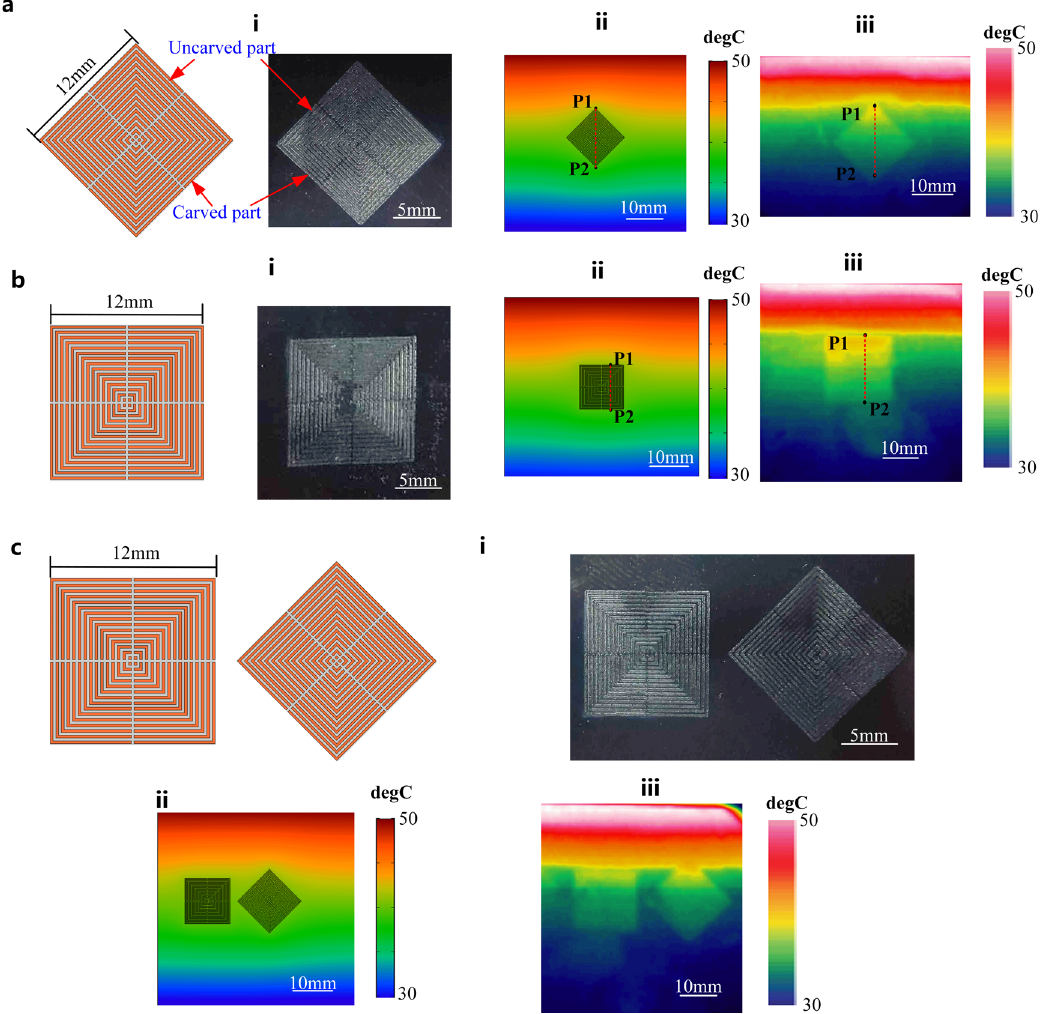
Fig. 3 Simulative and experimental performance evaluation of temperature map with the three models in contact with same temperature sources at both up and downsides. a (i) Model I metasurface composed of four TUBs. The side length of the model is 12 mm and the linewidth of the 0.2 mm. Simulative and experimental temperature maps of Model I are obtained by COMSOL simulation and IR camera. b (i) Model II metasurface. It is obtained by 45-degree rotation of the Model I metasurface. (ii and iii) Simulative and experimental temperature maps of Model II are obtained by COMSOL simulation and IR camera. c (i) Model III metasurface. It is composed of Model I and Model II metasurfaces. (ii and iii) Simulative and experimental thermal pro fi les of temperature-responsive with Model III metasurface are obtained via COMSOL simulation and IR